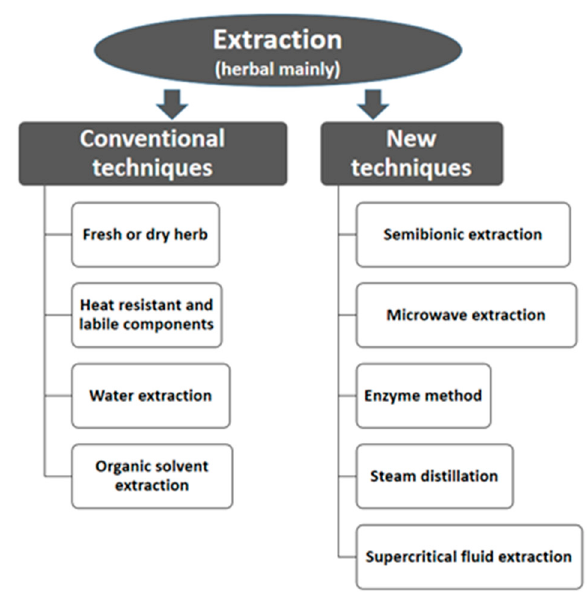
Figure 1 . Current extraction techniques for herbal medicines. Figure 1. Current extraction techniques for herbal